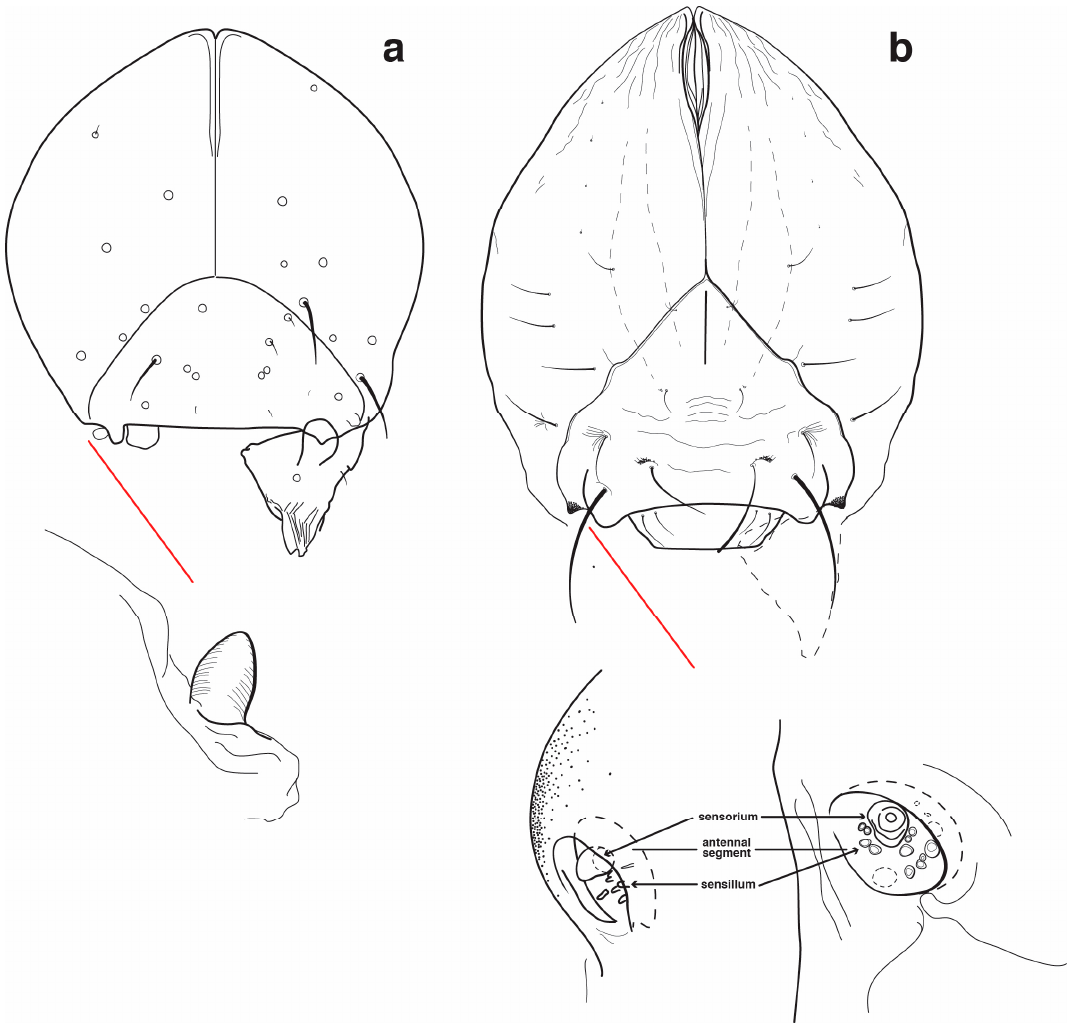
Figure 9. Head, dorsal view and detail of antenna: ( a ) Nephius (=Anius) ; and ( b ) Poteriophorus .